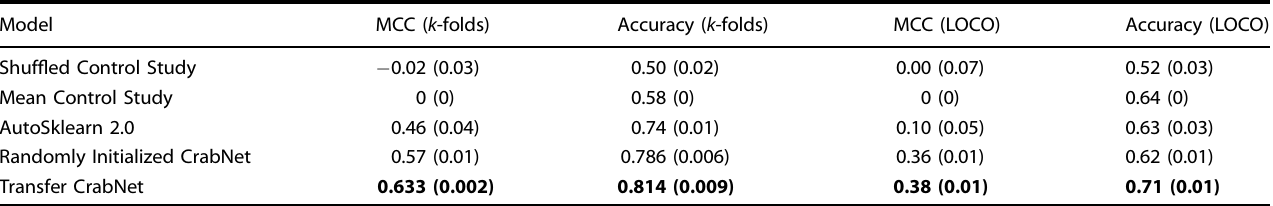
Table 4. Classi fi cation Performance Metrics Average results of each classi fi cation model predicting whether materials possess log 10 ( σ ) ≥ 4, judged by Matthews Correlation Coef fi cient (MCC) and accuracy under both dataset cross-validation